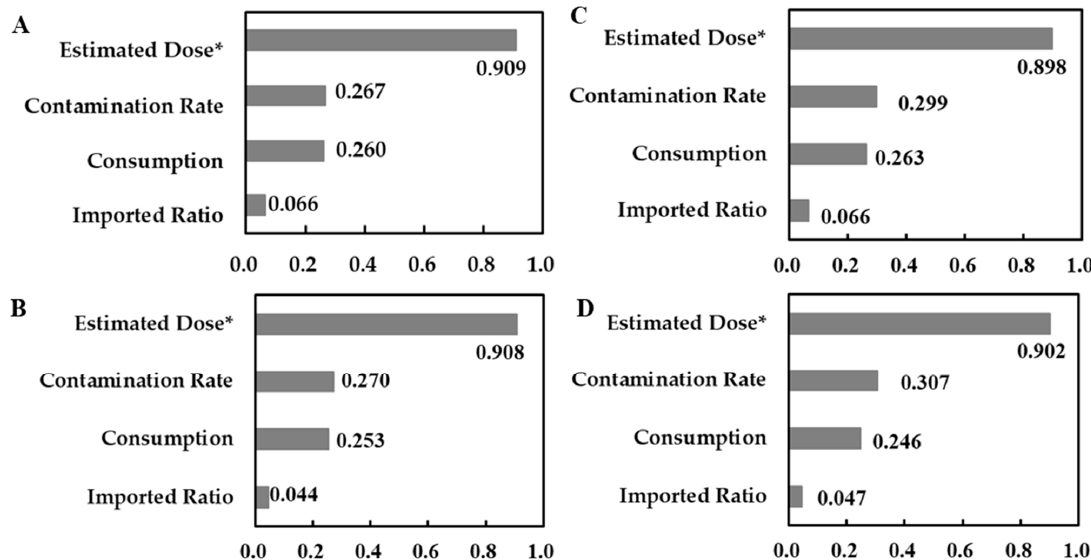
Figure 4. Rank correlation results of the sensitivity analysis for the consumption of rare and medium beef by males and females aged 19-65 years. ( A ) Males consuming rare beef, ( B ) males consuming medium beef, ( C ) females consuming rare beef, and (D) females consuming medium beef. *Unit: colony forming units.